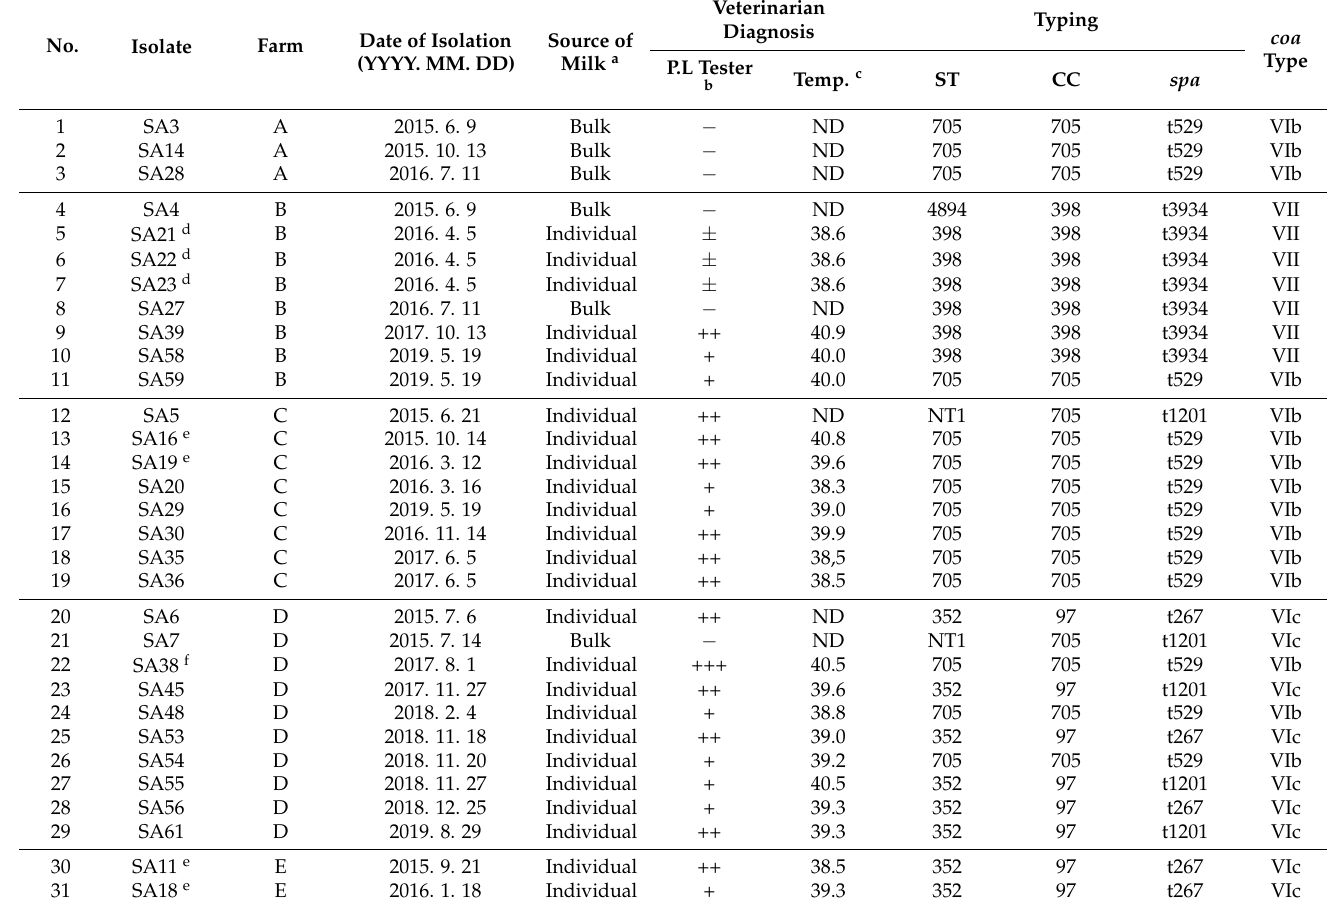
Table 1. Genetic typing of S. aureus isolates with veterinarian